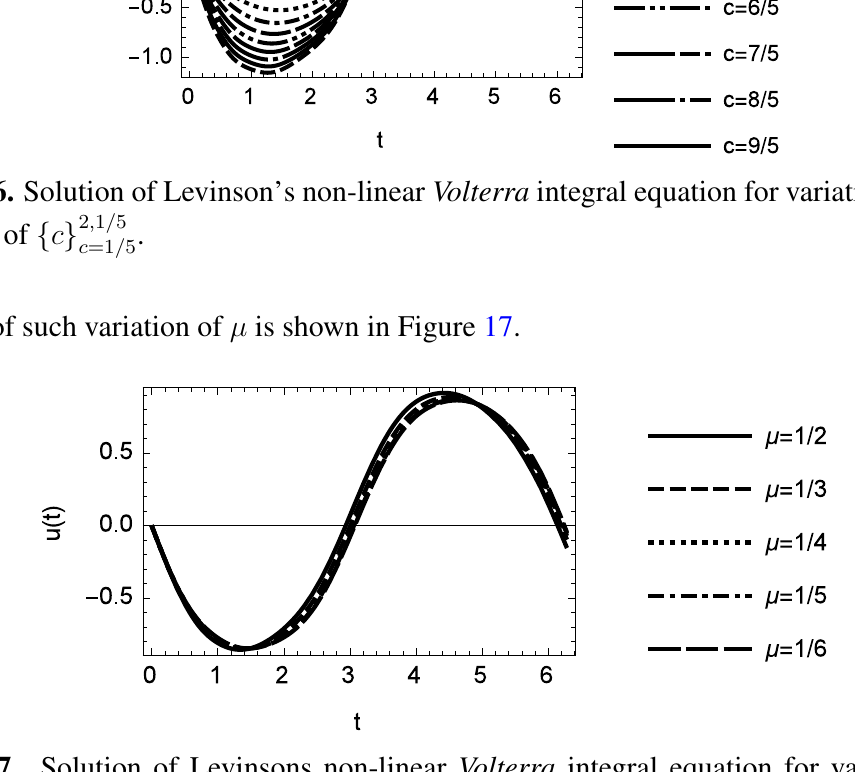
Figure 17. Solution of Levinsons non-linear Volterra integral equation for variations of (cid:22) = 1 =k in the range of f 1 =k g 6 k =2